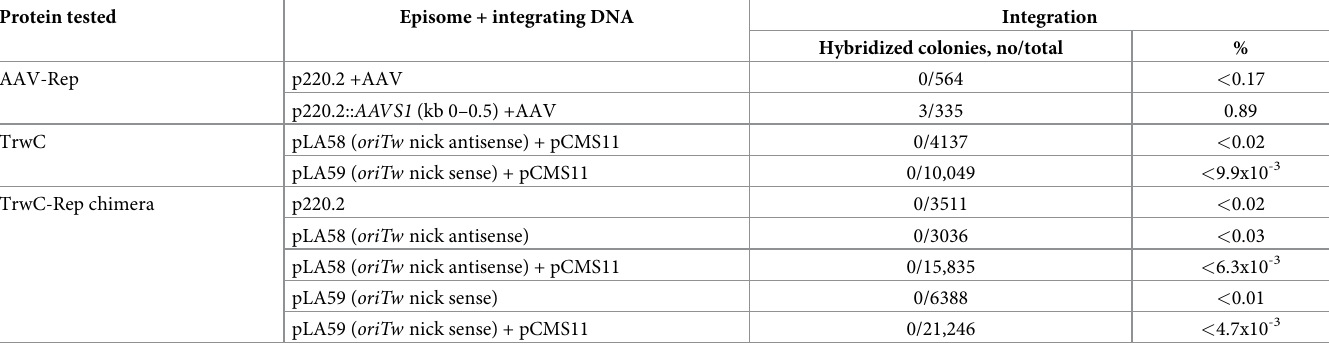
Table 2. Site-specific integration mediated by Rep, TrwC and TrwC-Rep using and episomal assay. Protein